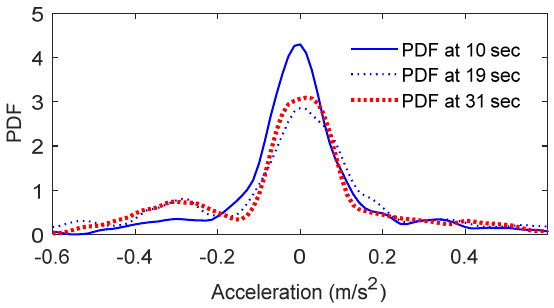
Figure 5. Evolution of probability density at different time instants.